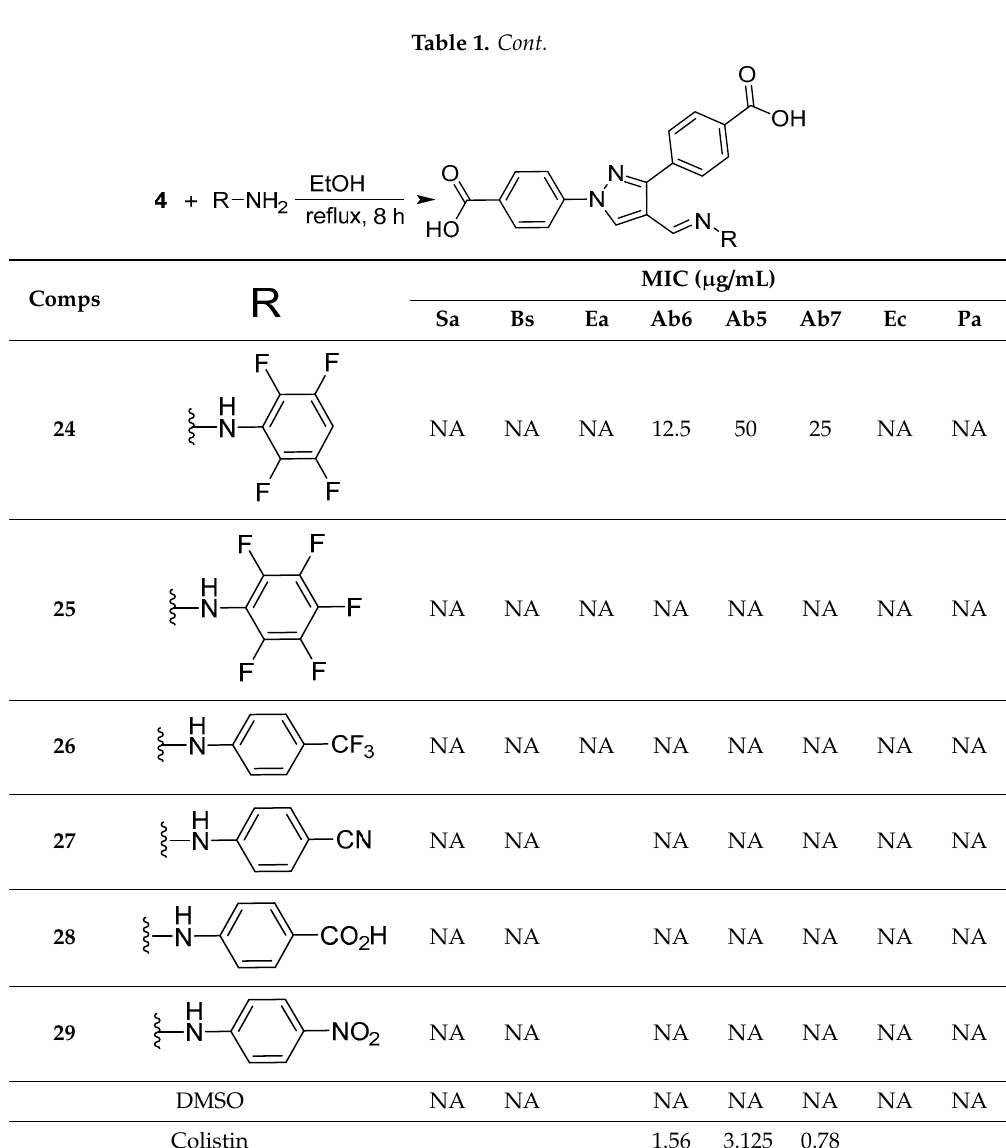
Gram-positive bacteria: Staphylococcus aureus ATCC 25,923 (Sa) and Bacillus subtilis ATCC 6623 (Bs), Gram-negative bacteria: Enterobacter aerogenes ATCC 13048 (Ea), Escherichia coli ATCC 25922 (Ec), A. baumannii ATCC 19606 , type strain (Ab6), A. baumannii ATCC BAA-1605 (Ab5), A. baumannii ATCC 747 (Ab7), Pseudomonas aeruginosa 27833 (Pa). and NA = no activity.